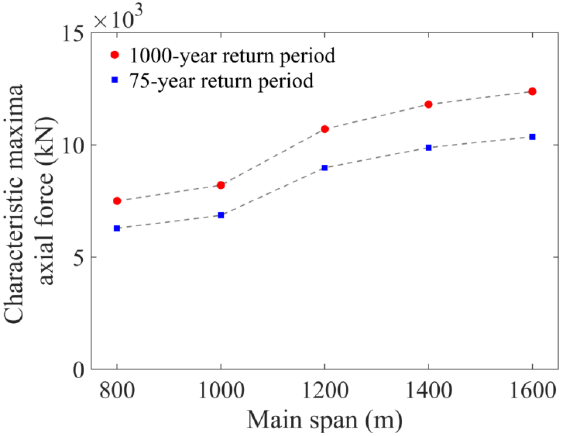
Figure 10. Characteristic maxima axial force for all five bridge lengths.